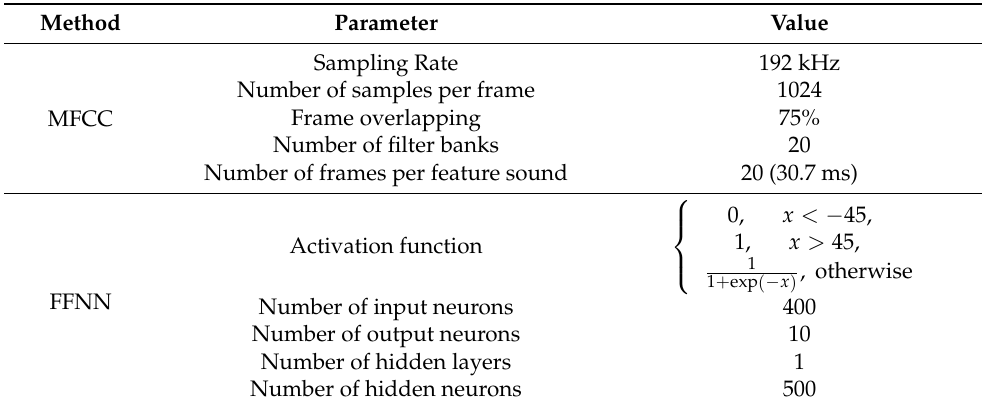
Table 1. Parameters of the MFCC-FFNN algorithm.